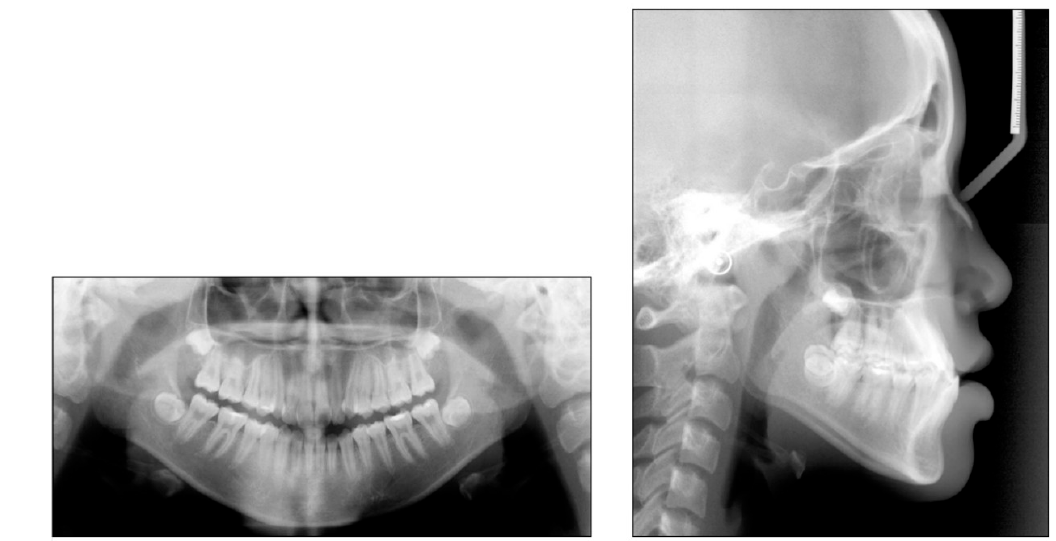
Figure 2. Case 1, Pretreatment panoramic radiograph and lateral cephalogram. Table 1. Case 1, Cephalometrci measurements.